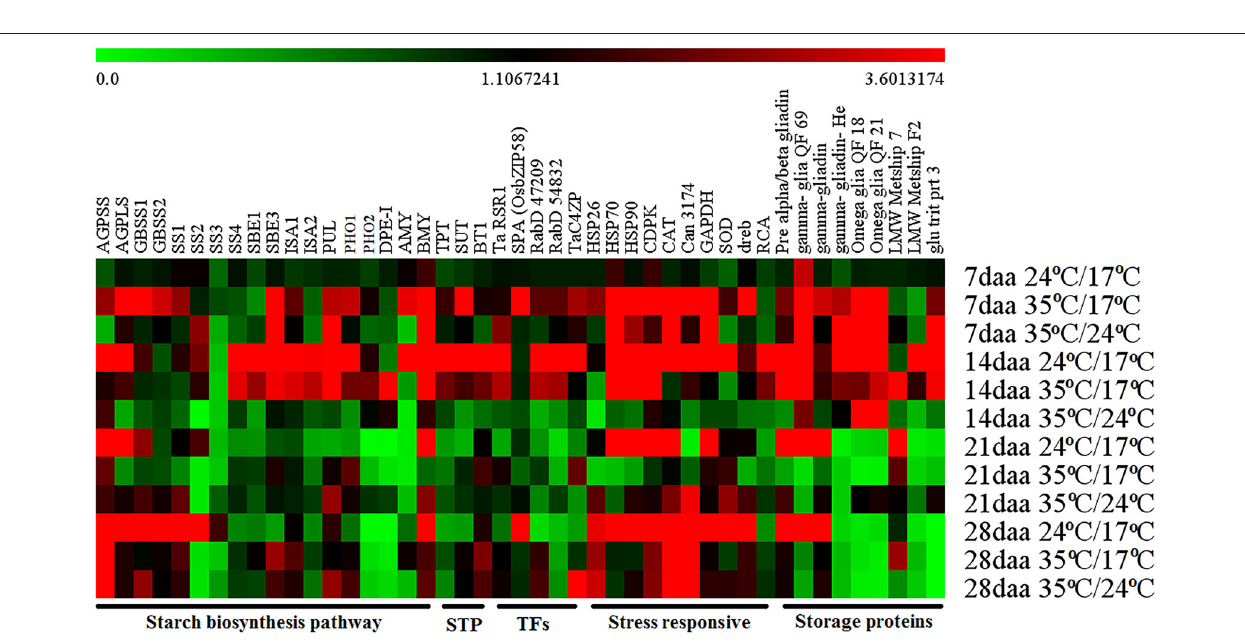
The second category included genes with high expression toward the later stage of seed development (28 DAA)